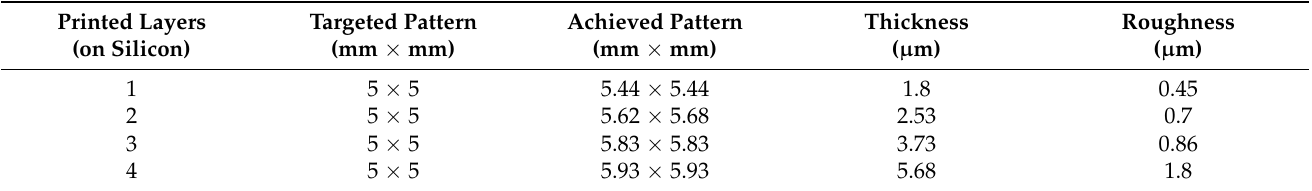
Figure 7. The thickness and roughness profile of 2.5%, and four printed layers of PVA. The average thickness and roughness were found to be 5.7 µ m and 1.8 µ m, respectively. Table 4 shows the summary of thickness and roughness profiles for different printed layers on Silicon. It is observed from the table that the spreading and roughness both increased with the increment of printed layers. Table 4. Thickness and roughness profiles for different printed layers of PVA.